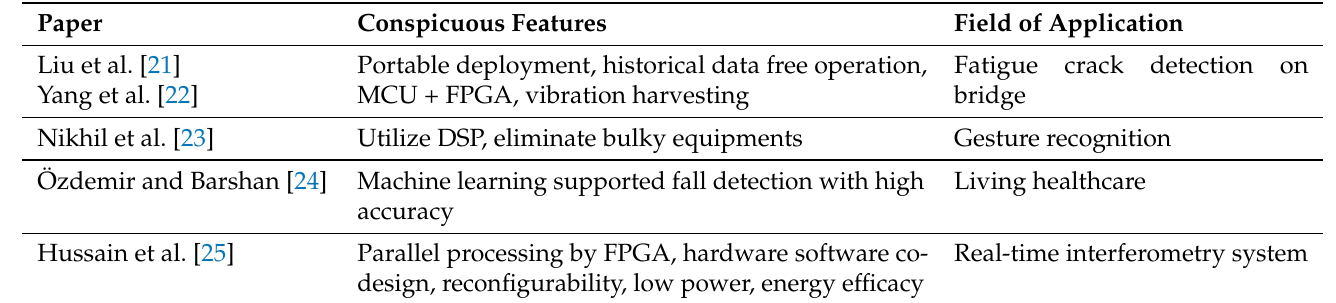
Table 2. Homogeneous sensor systems with system design